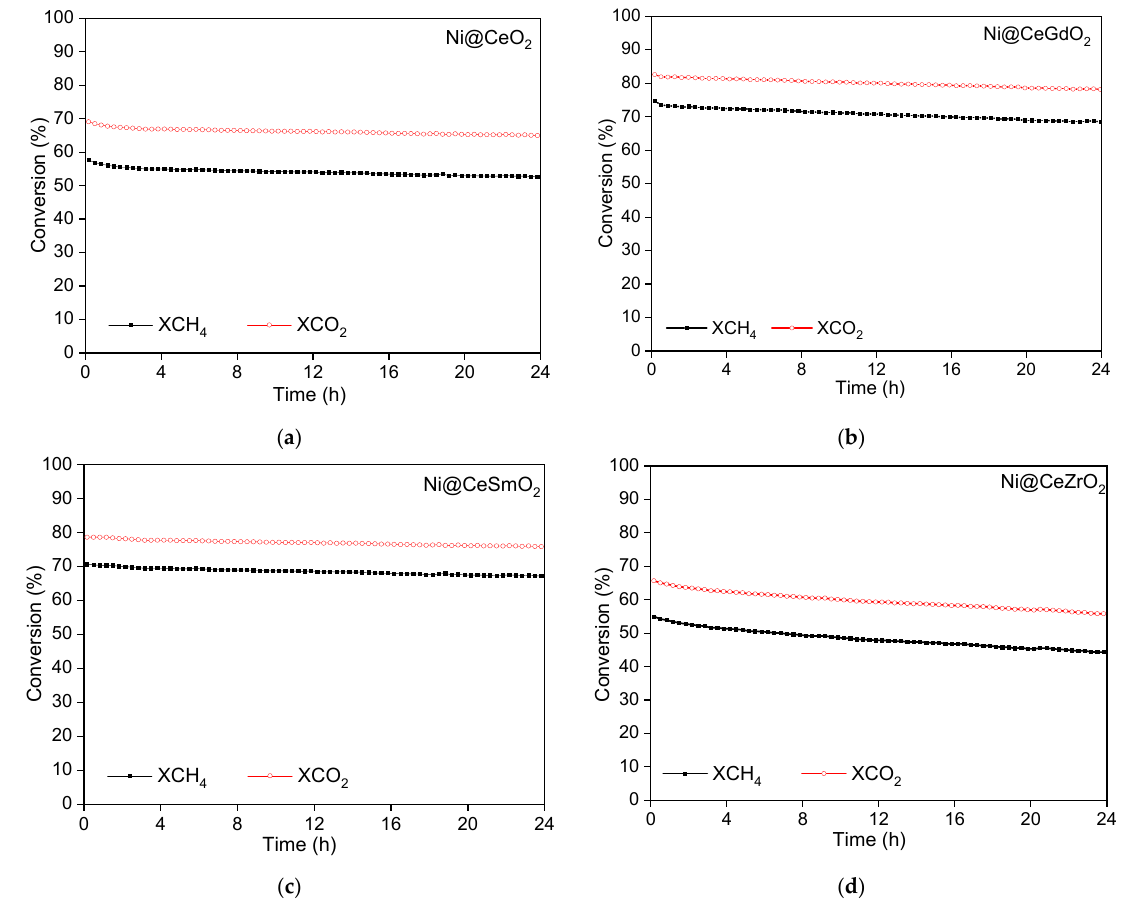
Figure 8. Conversion of CH 4 and CO 2 in the DRM at 800 °C as a function of TOS (CH 4 /CO 2 molar ratio of 1.0; W/F = 0.2 g cat .L − 1 h − 1 ) for ( a ) Ni@CeO 2 , ( b ) Ni@CeGdO 2 , ( c ) Ni@CeSmO 2 and ( d ) Ni@CeZrO 2 .